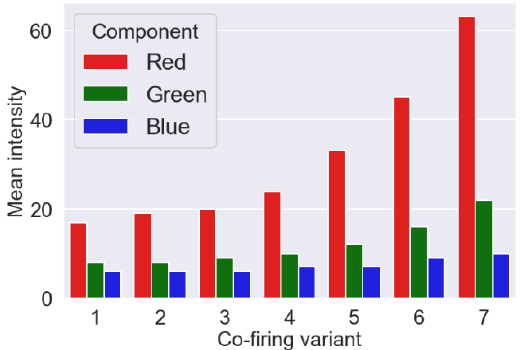
Figure 2. An average value of the color components for individual variants of the combustion process. The results presented in the graphs were obtained for the entire set of 1676 images for each variant.